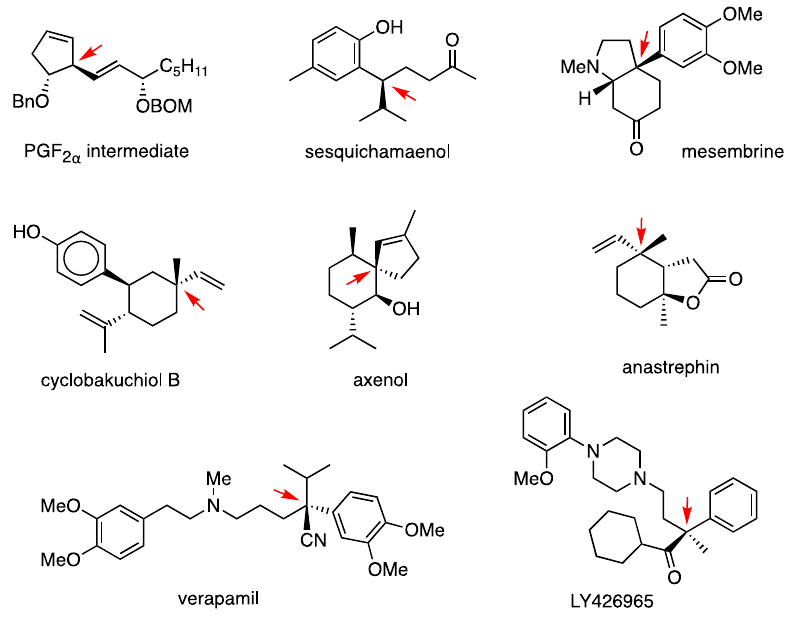
Figure 7. Biologically active compounds synthesized by using RMgX/CuCN 1 . 1 C–C bonds constructed by the anti -S N 2 ′ reaction are indicated by a red arrow.